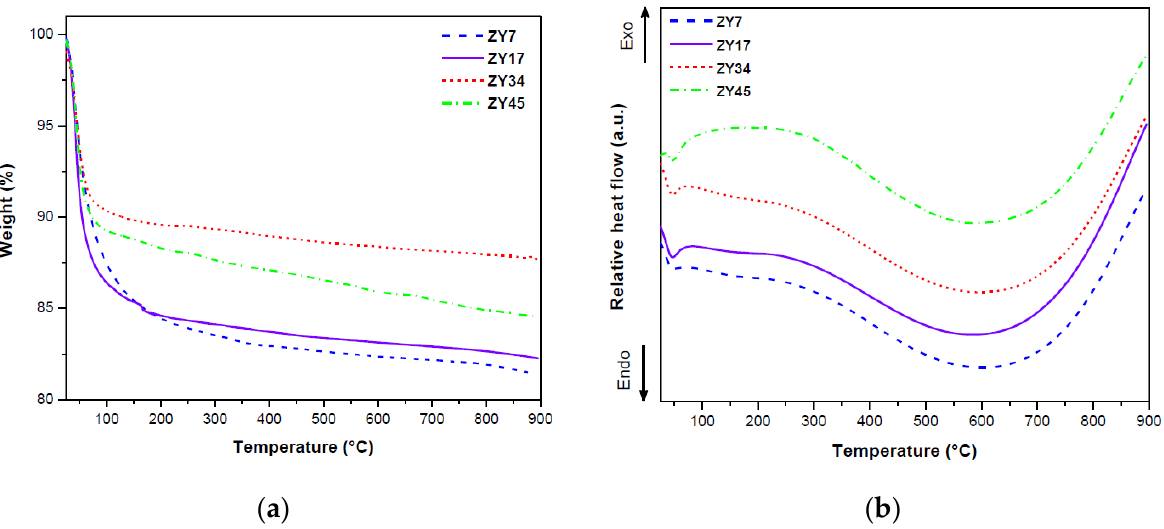
Figure 4. ( a ) Thermogravimetric analysis and ( b ) differential thermal analysis of the Y-type zeolites. The differential thermal analysis (DTA), shown in Figure 4b, exhibited